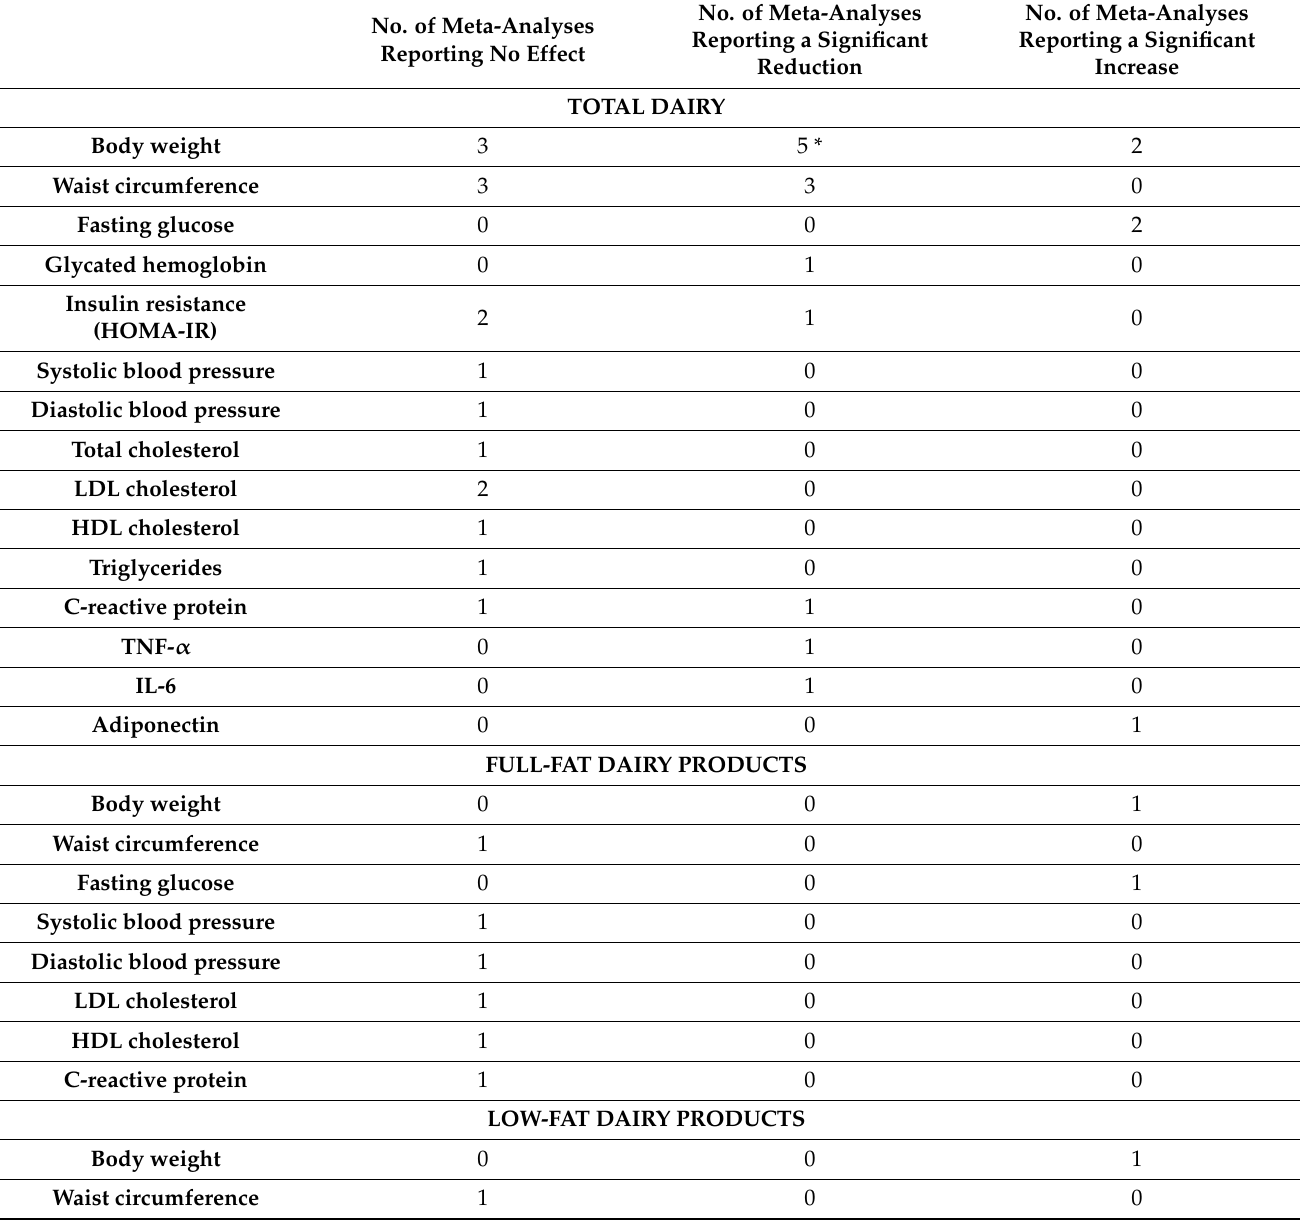
Table 2. Summary of the available meta-analyses of randomized controlled trials on the effect of dairy products on cardiovascular risk